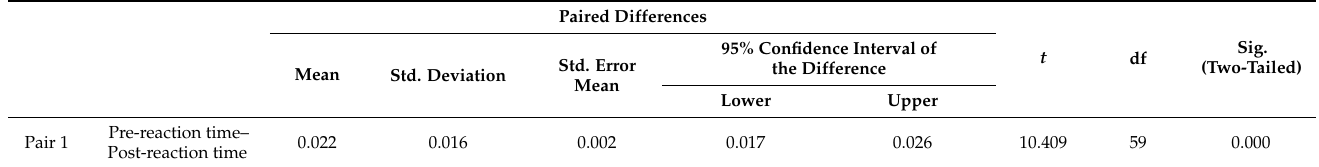
Table 3. Pre- and post-evaluation of statistical significance for improvement in the real-life reaction time.